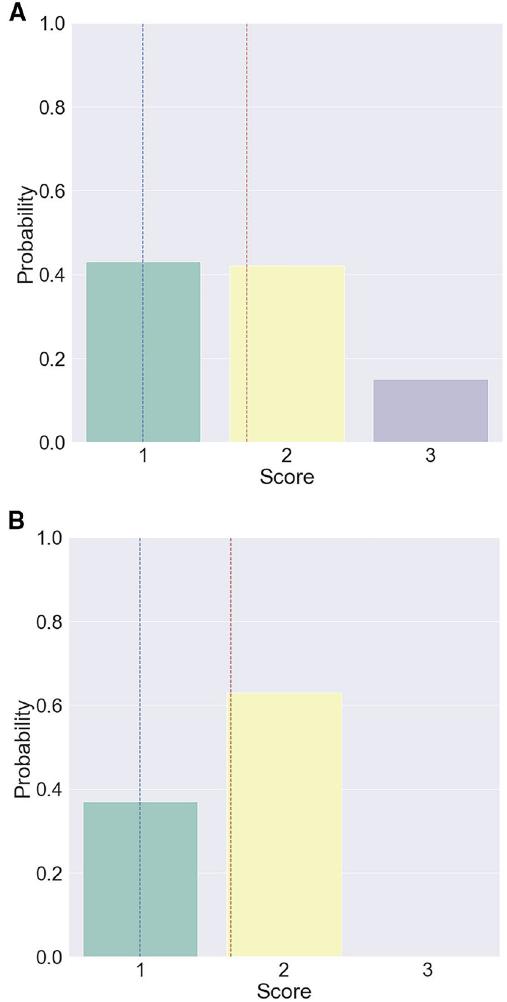
Figure 3. Example probability distribution inferred by the proposed model. The blue-dashed line indicates the actual score, and the red-dashed line indicates the expectation of the predicted PDS. If the model obtains a probability distribution as depicted in ( A ), it will be received a score of 1. Conversely, if a probability distribution similar to that depicted in ( B ) is obtained, its score will be miscalculated as